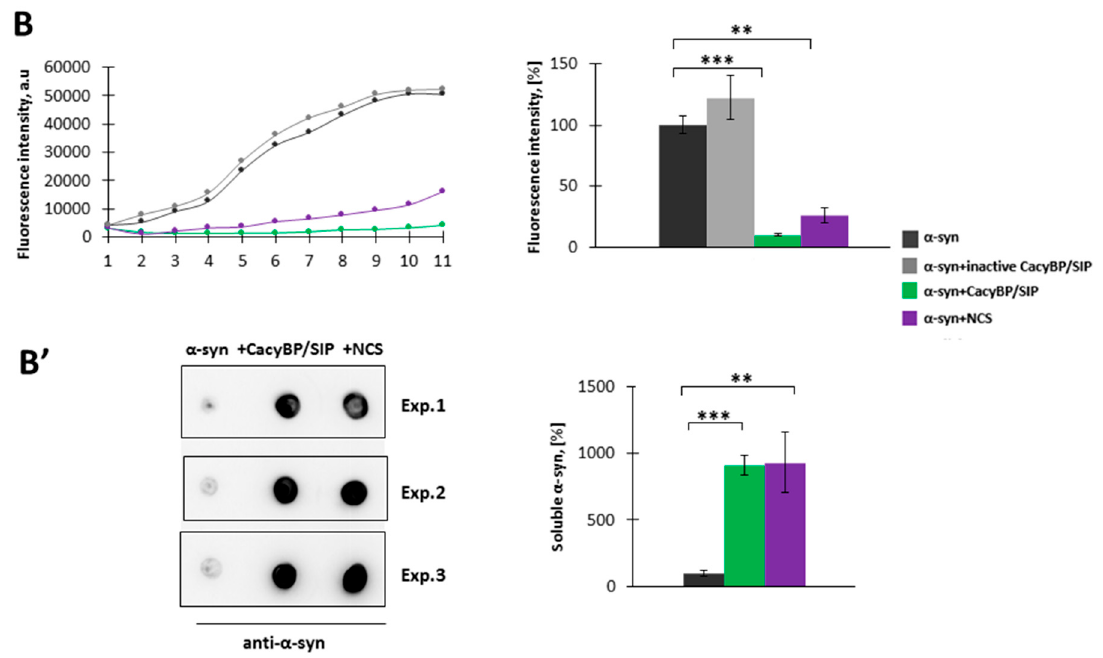
Figure 5. Influence of CacyBP/SIP domains on α -synuclein aggregation. ( A, left panel ) Representative curves showing ThT fluorescence of 30 µM α -synuclein alone (black) or in the presence of 30 µM: inactive CacyBP/SIP (grey), CacyBP/SIP (green), N domain (orange), CS domain (yellow) or SGS domain (brown). ( A, right panel ) Statistical analysis of the results ( n = 3). ( A’, left panel ) Dot-blots showing α -synuclein immunostaining in the soluble fraction and ( A’, right panel ) statistical analysis of the results ( n = 3). (B, left panel) Representative curves showing ThT fluorescence of 30 µM α -synuclein alone (black) or in the presence of 30 µM: inactive CacyBP/SIP (grey), CacyBP/SIP (green) or NCS fragment of CacyBP/SIP (violet) ( B, right panel ) Statistical analysis of the results ( n = 3). ( B’, left panel ) Dot-blots showing α -synuclein immunostaining in the soluble fraction and ( B’, right panel ) statistical analysis of the results ( n = 3). In all cases, samples were taken on day 4 of incubation and data, calculated as means ± SEM, are presented as percentage values. ** p ≤ 0.01, *** p ≤ 0.001.